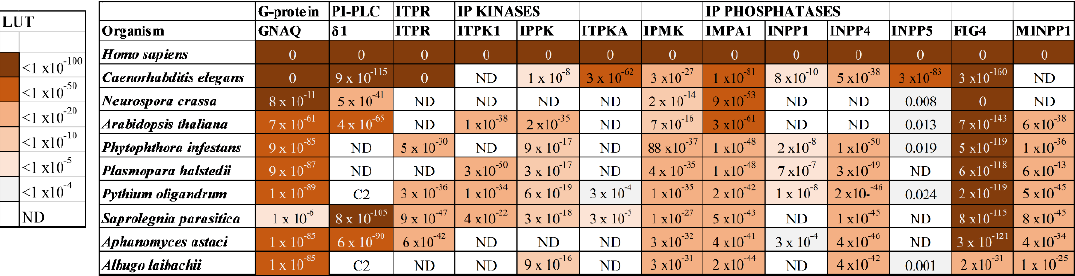
Figure 2. Oomycete genomes encode putative G α q/11 subunits, IP kinases and IP phosphatases, but only members of the Order Saprolegniales possess detectable PI-PLC homologues.